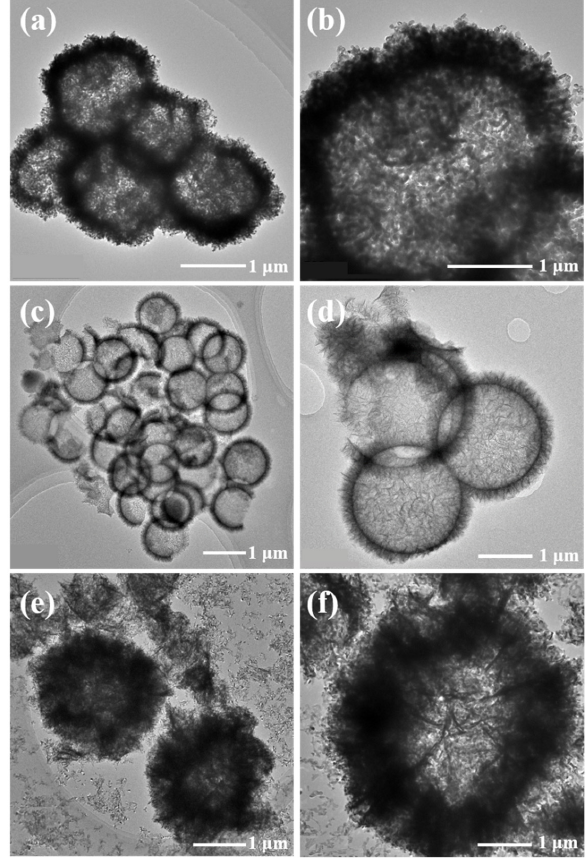
Figure 4. The TEM of ( a , b ) NiO-P, ( c , d ) NiO-N, ( e , f ) NiO-S.